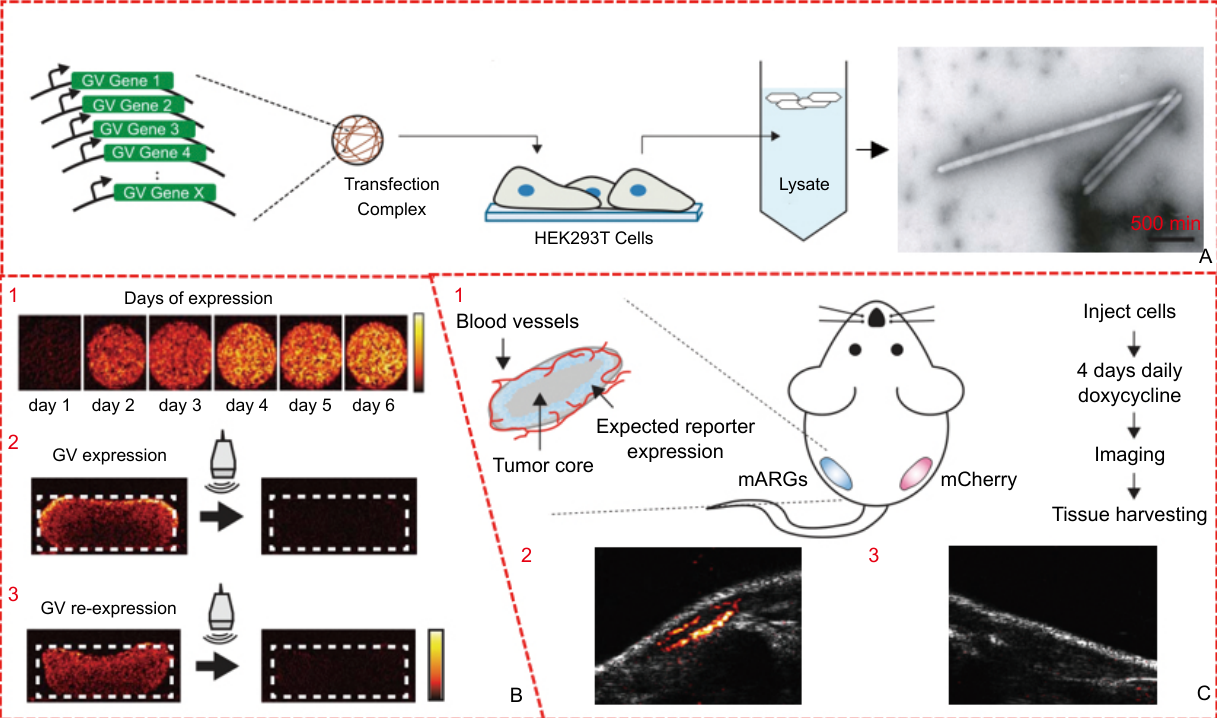
Figure 4 (A) Schematic of the transient cotransfection assay used to identify combinations of genes capable of producing gas vesicles in mammalian cells, and representative TEM image of purified gas vesicles expressed in HEK293Tcells; (B1) Representative ultrasound images and contrast measurements in mARG-HEK cells as a function of time; (B2) Schematic and representative ultrasound images of gas vesicles (GV) expression from mARG-HEK cells in Matrigel; (B3) Re-expression of gas vesicles (GV) after acoustic collapse; (C1) Diagram of a mouse implanted with a subcutaneous tumor model, and the expected spatial pattern of vascularization and doxycycline-induced reporter gene expression; (C2) Representative ultrasound image of tumors containing mARG-HEK cells after 4 days of doxycycline administration. mARG-specific contrast shown in the hot color map is overlaid on an anatomical B-mode image showing the background anatomy; (C3) Representative ultrasound image of tumors containing mCherry-HEK cells after 4 days of doxycycline administration. (Reproduced with permission from